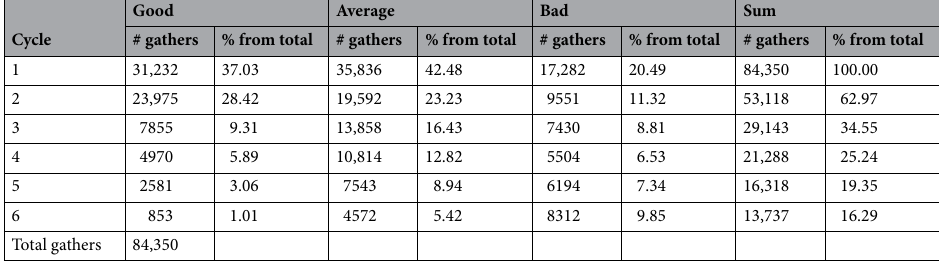
Table 1. Number of gathers classified as good, average, or bad in each cycle of the experiment for DS2. The numbers are also given as percentages from the total number of gathers.